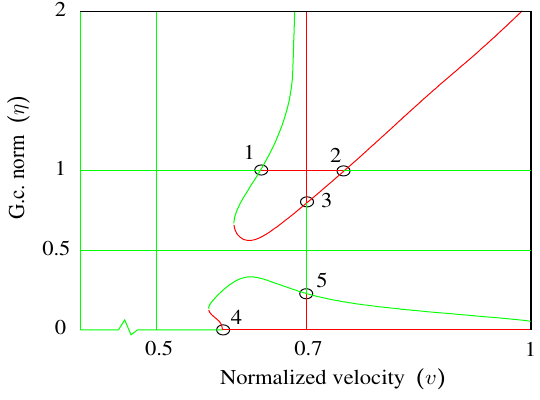
Figure 8. Five start points for LCO curves (Green means stable, red means